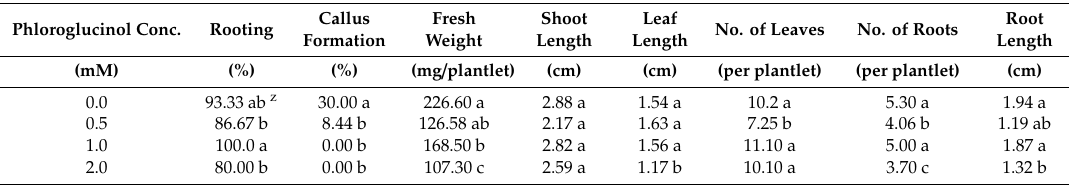
Table 3. E ff ects of various concentrations of phloroglucinol on rooting and callus formation in